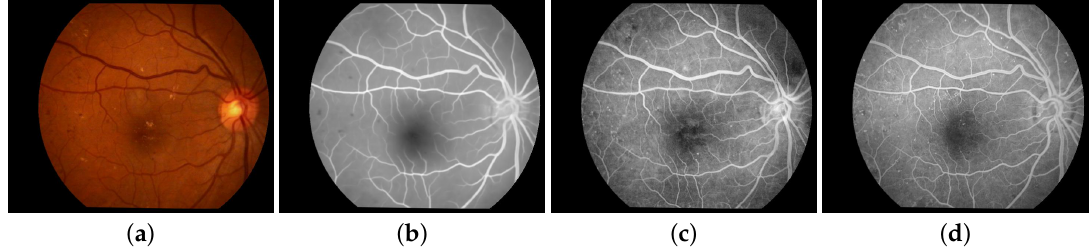
Figure 1. Examples of ( b , c ) generated angiographies together with ( a ) the original retinography and ( d ) the real angiography. ( b ) Generated using the paired approach. ( c ) Generated using the unpaired